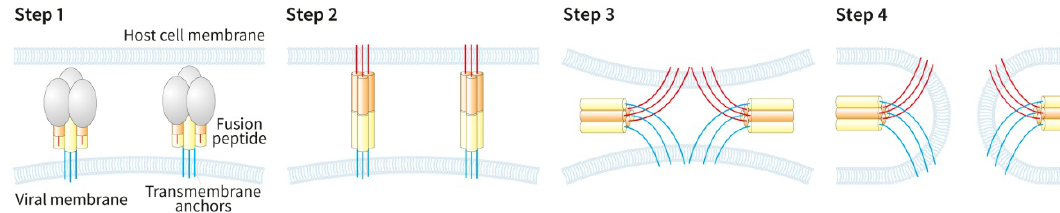
Figure 3. A model for membrane fusion by enveloped viruses by fusogenic viral proteins. Conformational changes in the fusogenic protein in the low pH endosomal compartment expose a fusogenic peptide which in Step 2 interacts with the host membrane followed by further structural rearrangements leading to the classical “hairpin” configuration as